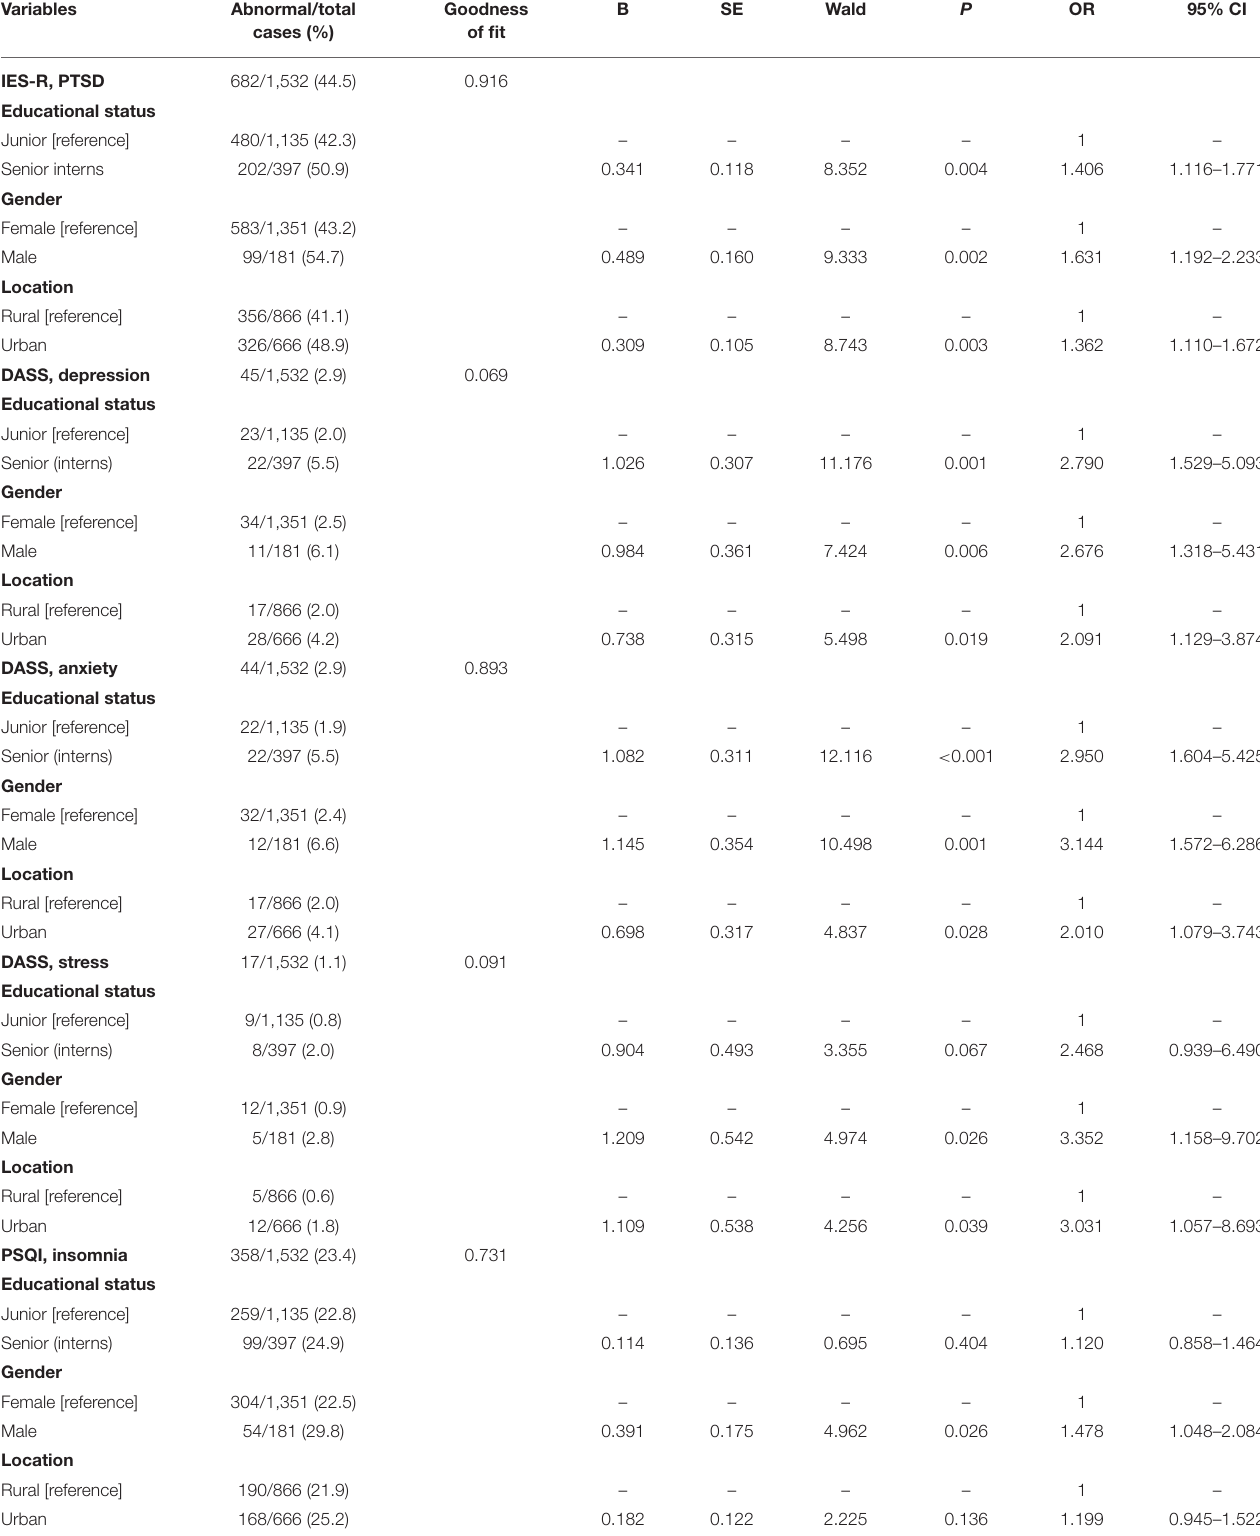
TABLE 4 | Logistic regression analysis for PTSD, depression, anxiety, stress, and insomnia risk